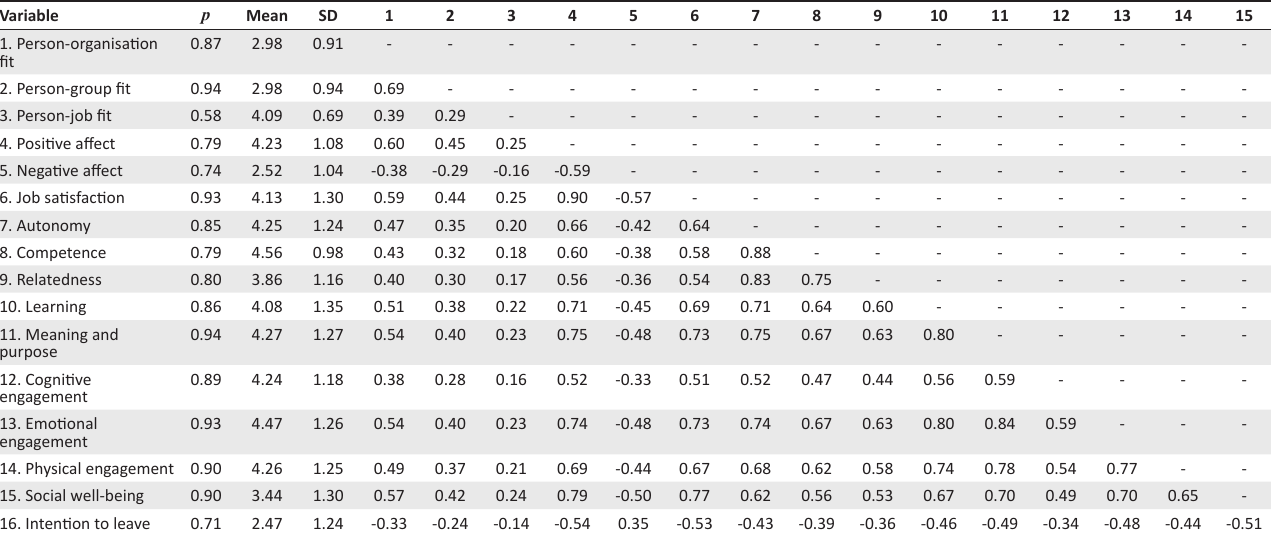
Table 4: Reliability coefficients and correlations of the scales ( n = 339). Variable